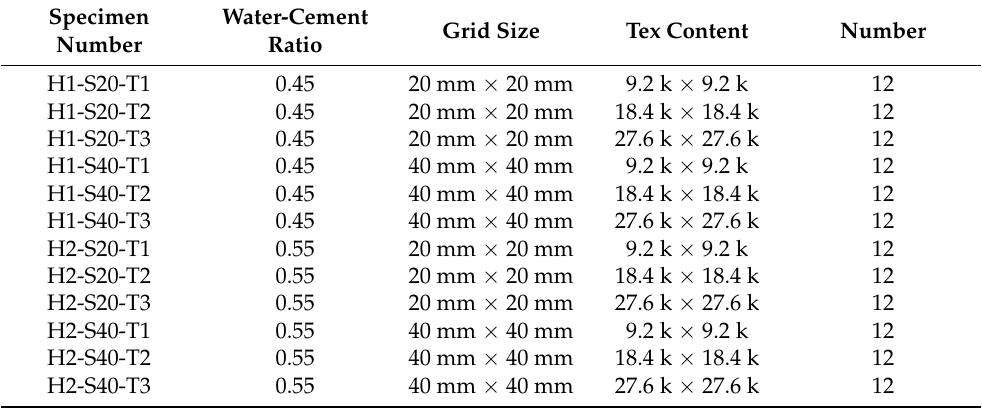
Table 4. Differences of specimens.